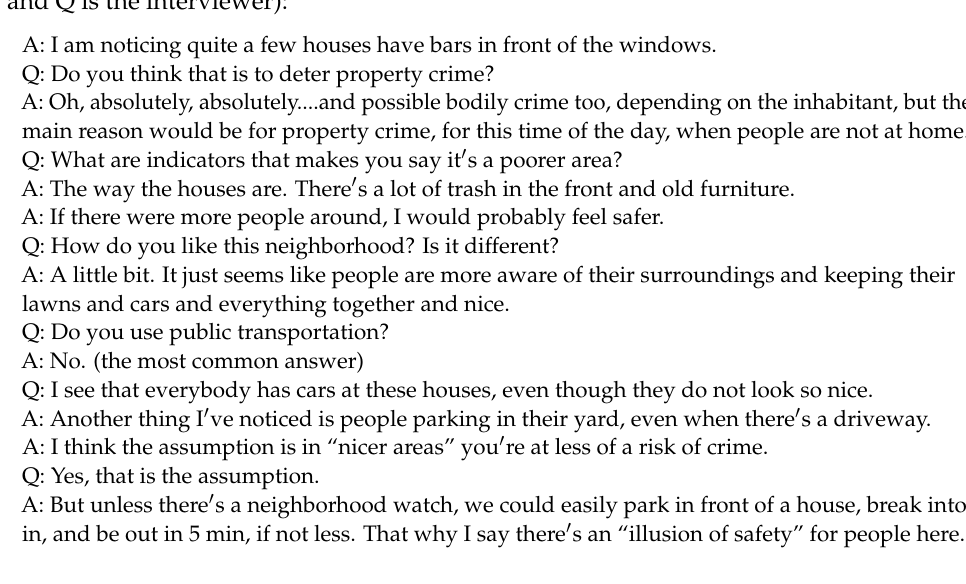
Figure 11. Route traveled by test participants overlaid on top of results of sentiment analysis based on transcripts of ten geonarratives: KDEs of positive polarity (left) and negative polarity (right).